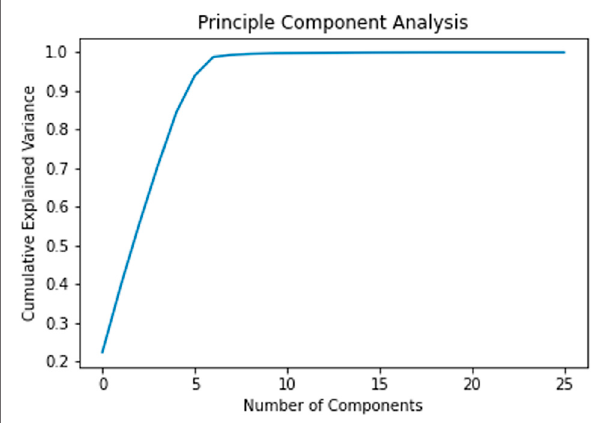
FIGURE 2 | Cumulative explained variance across different principle